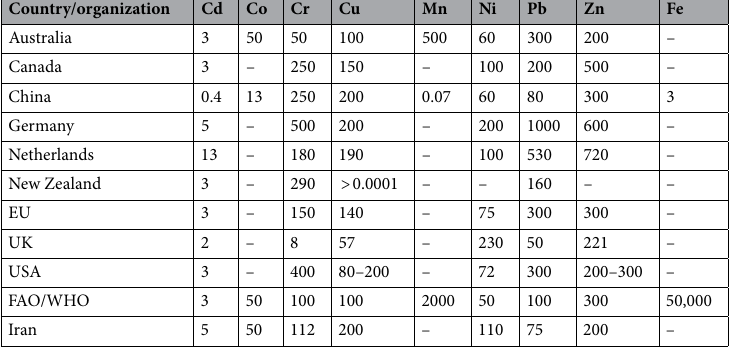
Table 4. Regulatory standards of TEs in agricultural soils (mg/kg) 4,70,83–89 .